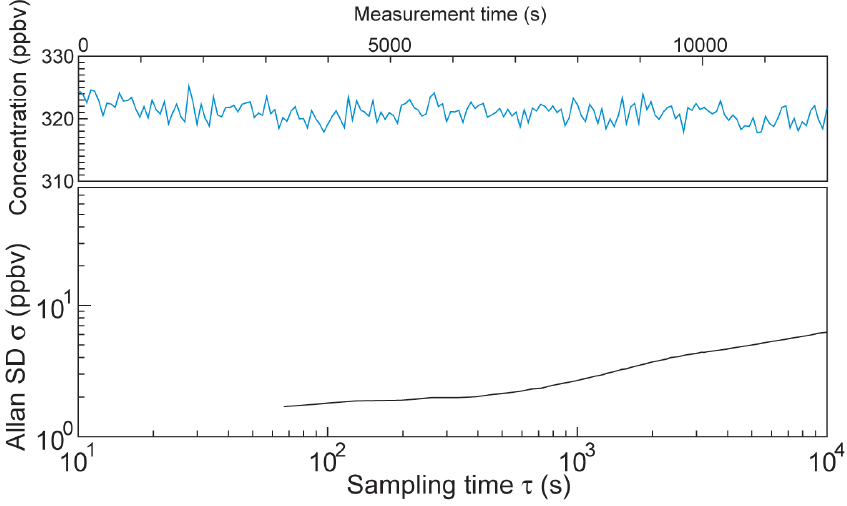
Figure 6. Allan variance plot and concentration variation for N over a 3 h period with a 1 min averaging